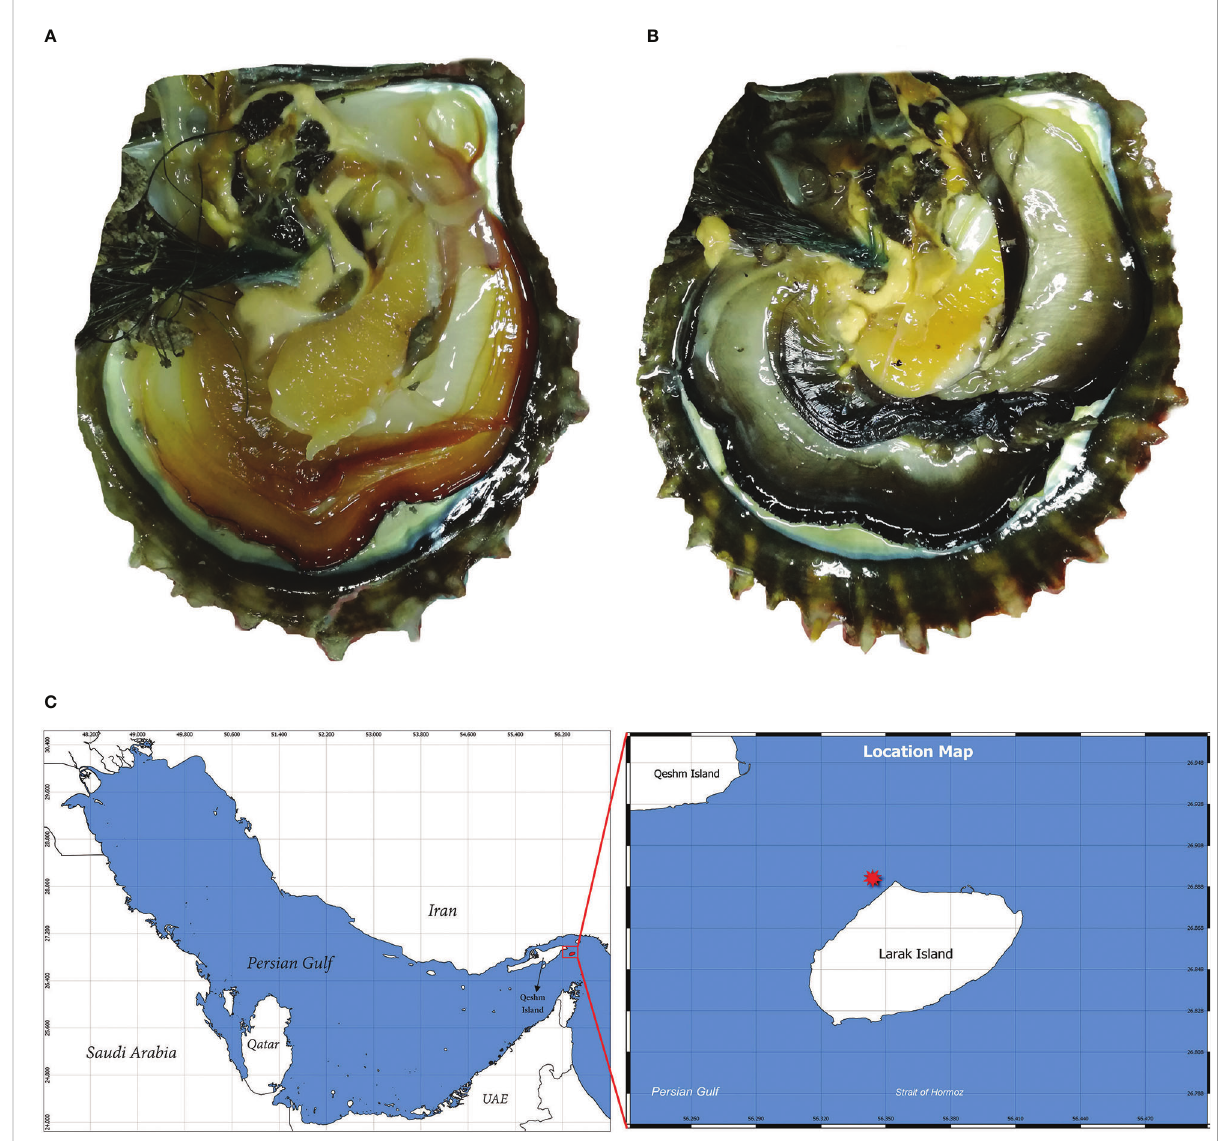
FIGURE 1 Two common morphotypes of Pinctada persica found in Persian Gulf which were investigated in this study. (A) Orange morphotype, (B) Black morphotype. (C) Sampling site on Larak Island, Persian Gulf, Iran. The map was created using QGIS Desktop (Version 3.